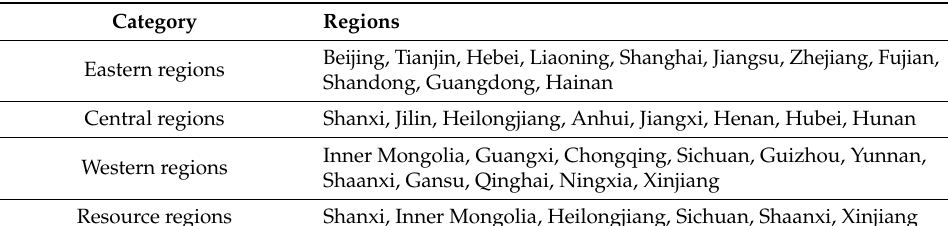
Table 4. Classification of